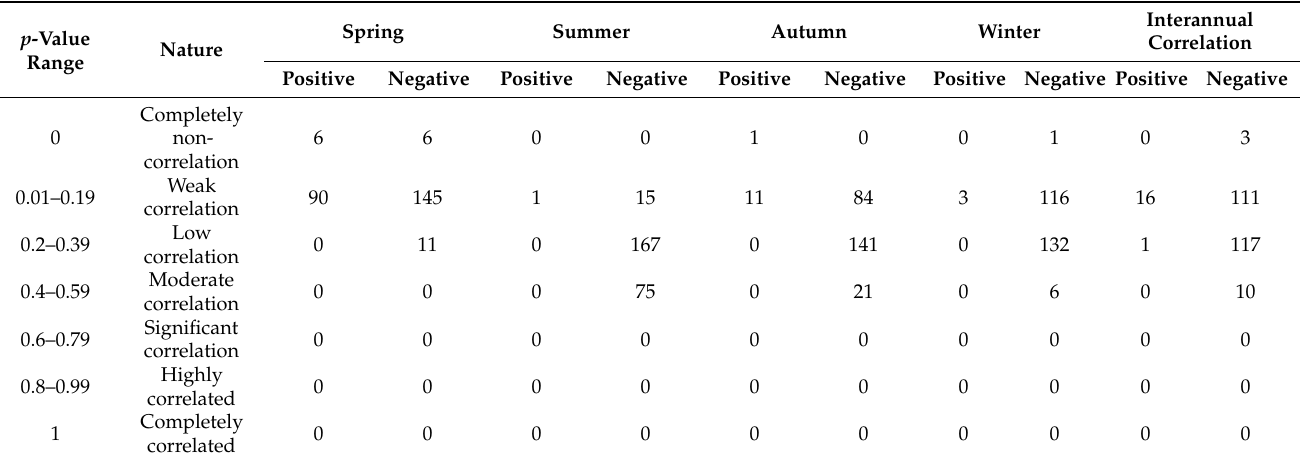
Table 3. Distribution of statistics for the p -values corresponding to different numbers of stations in the Haihe River Basin. p -Value Range